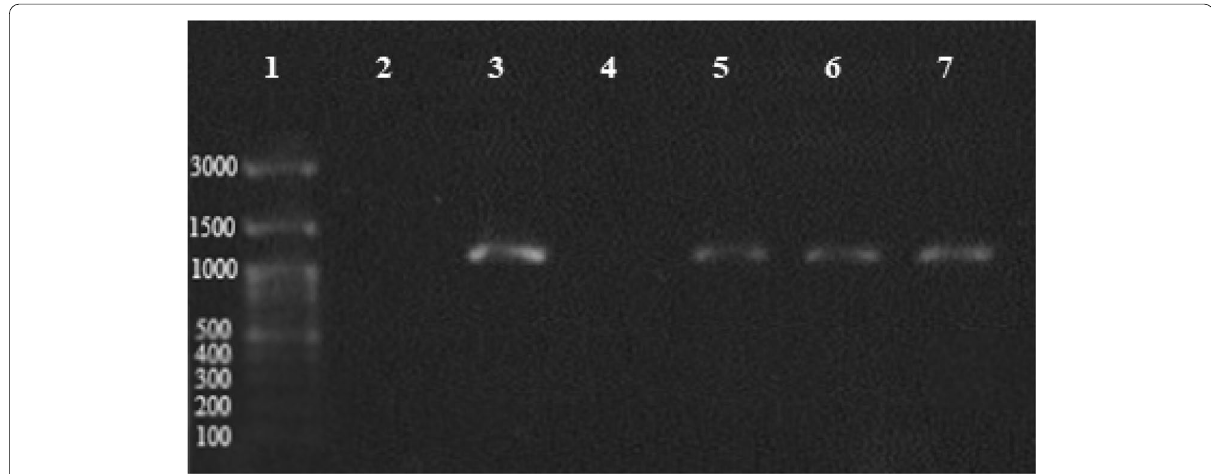
Fig. 4 Illustration of bla TEM PCR product on 1% agarose gel; lane 1, size marker (ladder 100 bp: SMO321 , Fermantas ); lane 2, negative control; lanes 3 and 5–7, positive bla